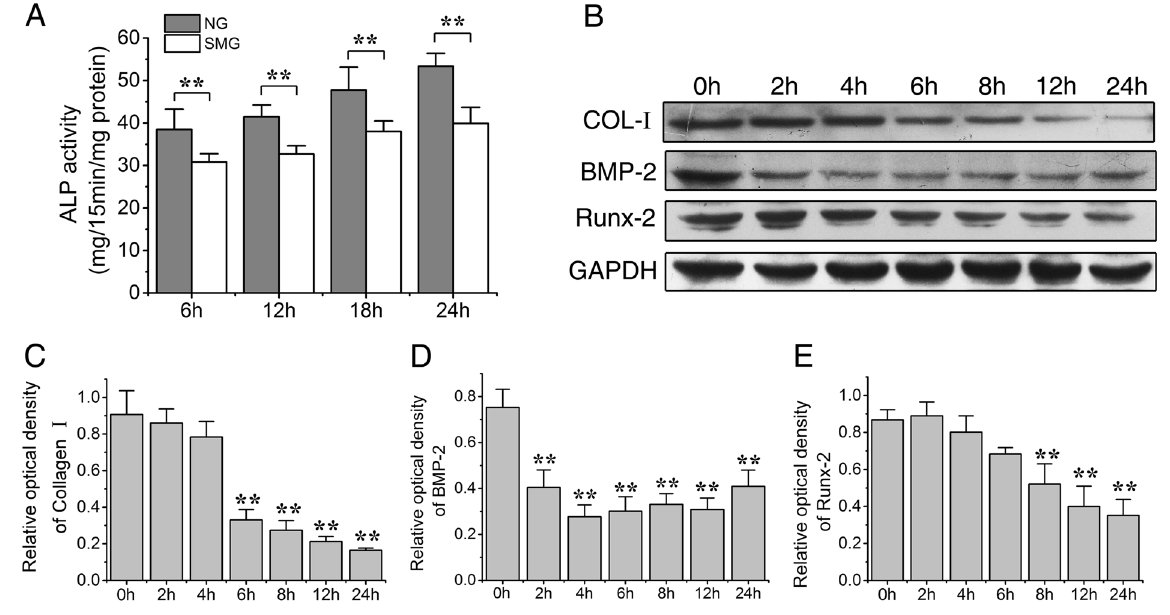
Figure 3. Simulated microgravity inhibits the osteogenic differentiation of rat calvarial osteoblasts (ROBs). ( A ) The alkaline phosphatase (ALP) activities after ROBs were exposed to simulated microgravity (SMG) and normal ground (NG) for different time periods. ( B ) Representative Western blots detecting the expression levels of osteogenesis markers, COL-I, BMP-2 and Runx-2 (with GAPDH as a control) in ROBs at different time points after random positioning machine (RPM) exposure. ( C ) Relative protein levels of COL-I, BMP-2 and Runx-2. NG: normal ground, SMG: simulated microgravity. Full-length Western blots are presented in Supplementary Figure 2. Each experiment was conducted at least three times independently. * P < 0.05 or ** P < 0.01 vs NG group or 0 h group.